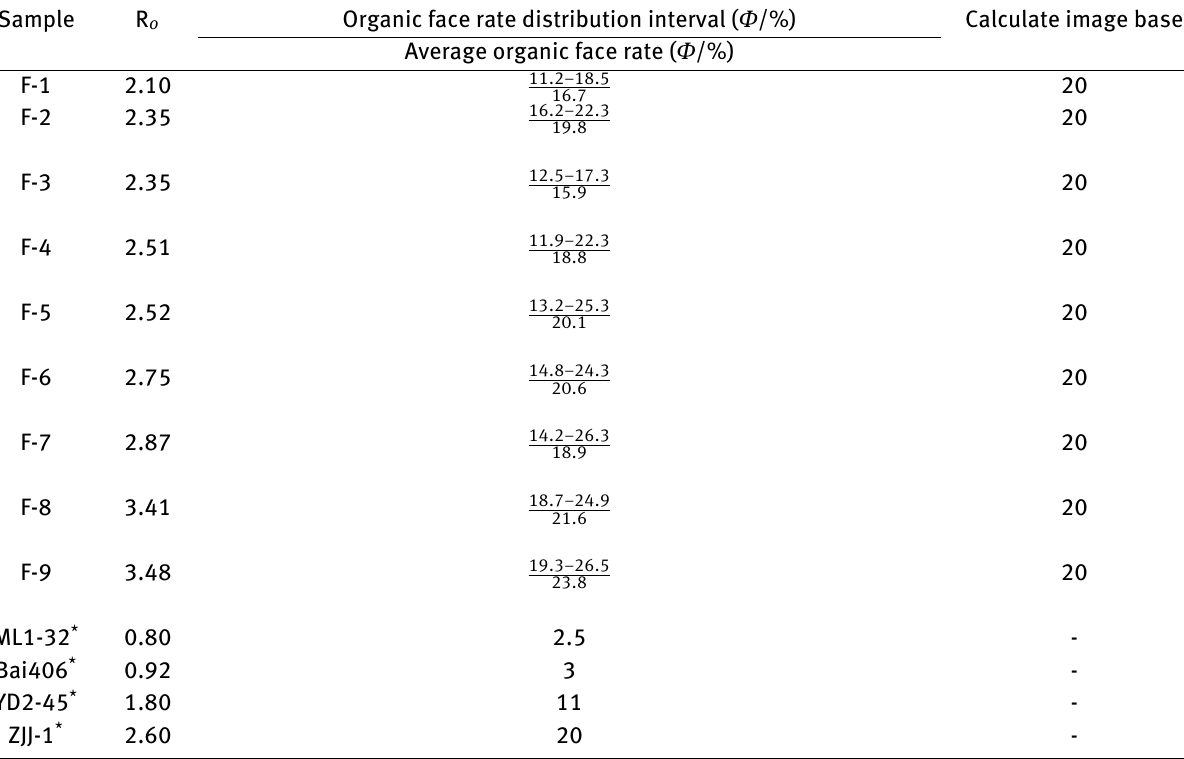
Table 3: Shale organic matter face rate calculation